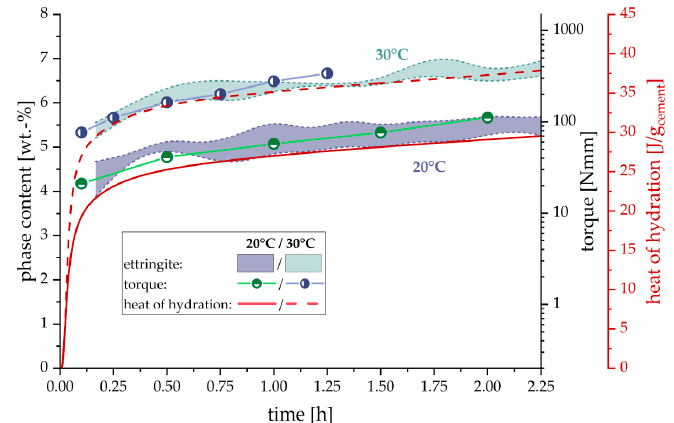
Figure 3. Comparison of ettringite content, rheological properties and heat of hydration during the first two hours of hydration at 20 °C and 30 °C (w/c = 0.36). Note that the phase content and the heat of hydration are linearly scaled whereas the torque is scaled logarithmically. Ettringite content is displayed as colored background with respect to the 3 independent measurements.